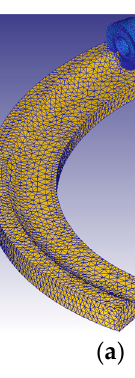
Figure 5. FE simulation. ( a ) FE models of the insert and workpiece, ( b ) Simulation process.